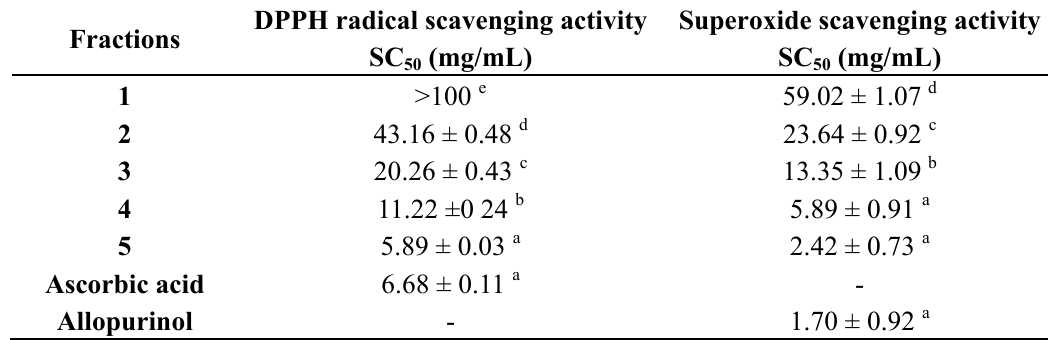
Values represent means ± S.D . of three determinations. Values bearing different superscripts in the same column are significantly different ( p <